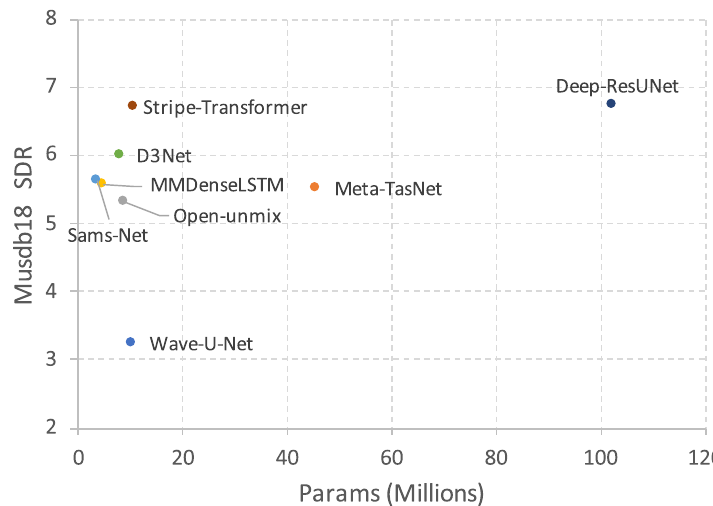
Fig. 5 Performance vs. model parameters on the Musdb18 dataset. Fewer parameters and higher SDR score are better